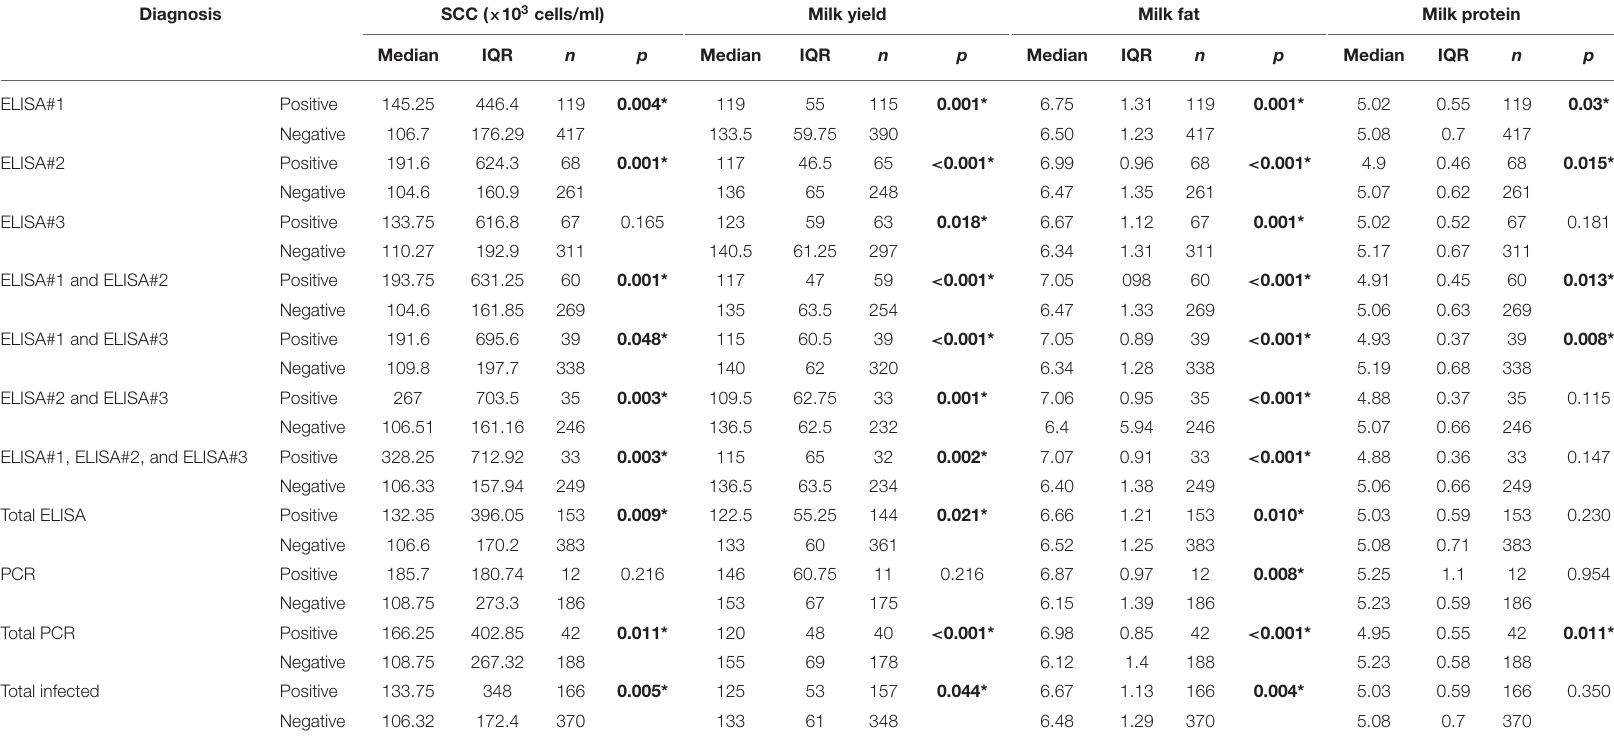
TABLE 6 | Milk production parameters evaluated in Flocks C and D from the Latxa breed according to SRLV infection status.